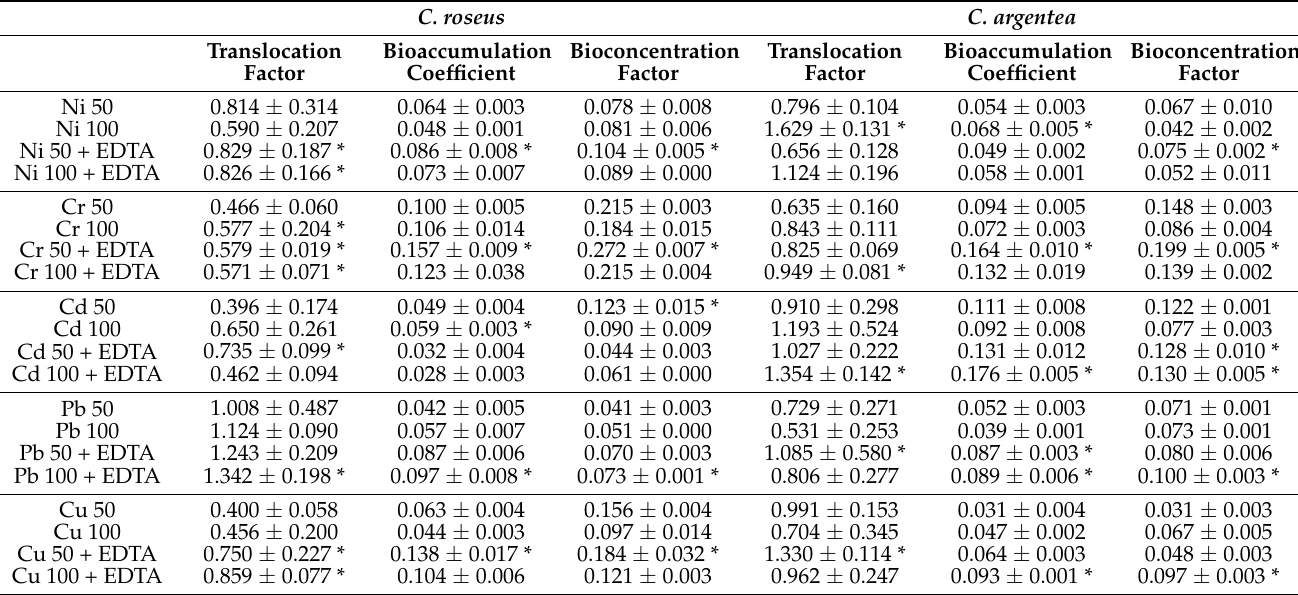
Table 5. Calculated translocation factor, bioaccumulation coefficient, and bioconcentration factor of Catharanthus roseus and Celosia argentea concerning metal concentrations and EDTA